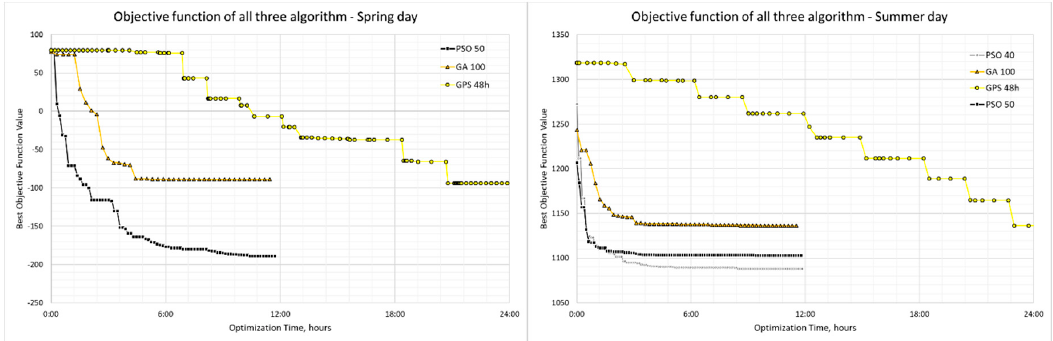
Figure 16. Optimum solutions of all three algorithms on the selected spring day (on the left) and the summer day (on the right).